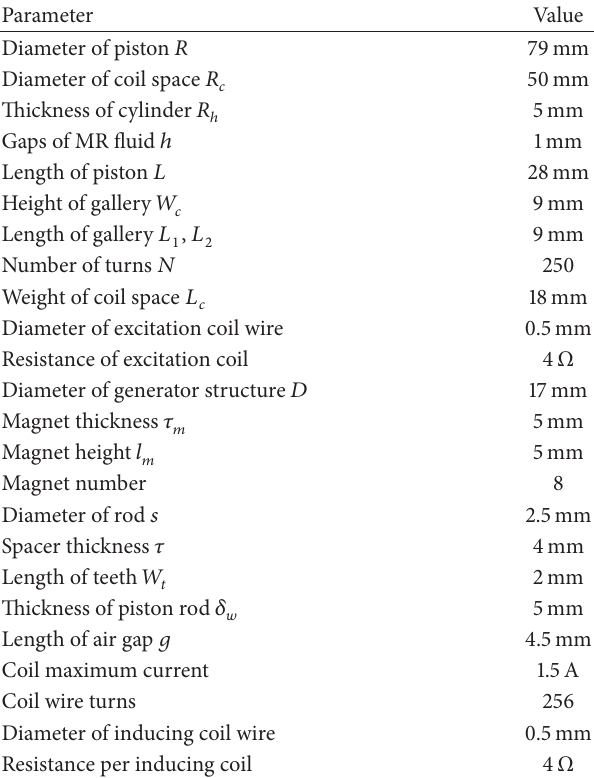
Table 1: Specifications of the proposed MR